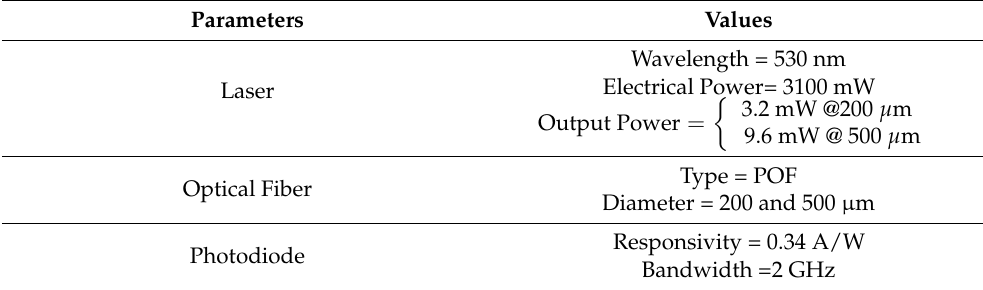
Table 2. Testbed